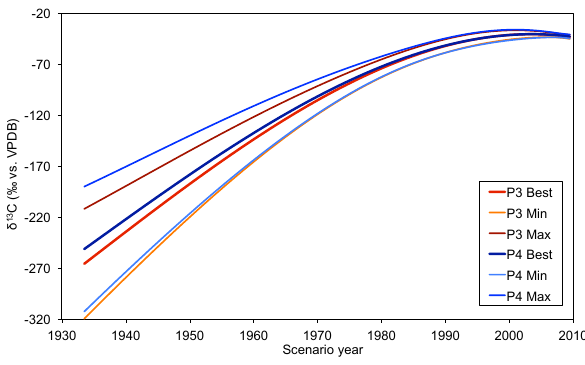
Fig. 7. CFC-12 δ 13 C 3rd (red shades) and 4th (blue shades) degree polynomial forward model results and mean firn data (green) with depth. The envelopes show the overall minimum and maximum val- ues of all selected